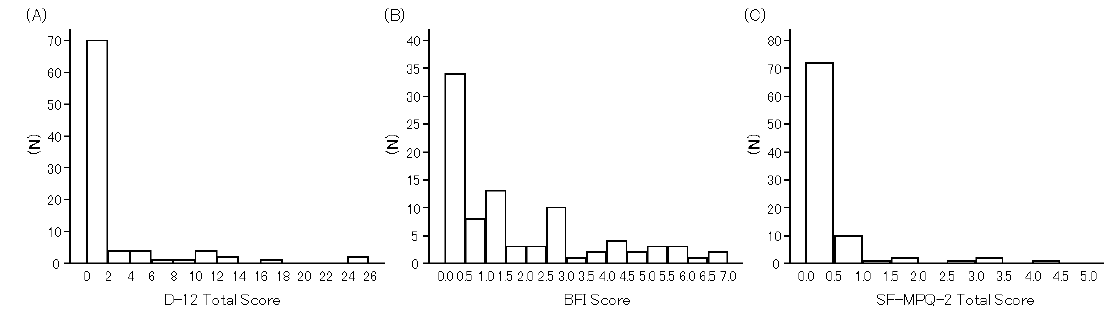
IQR, interquartile range; BFI, Brief Fatigue Inventory; SF-MPQ-2, Short-form McGill Pain Questionnaire 2; D-12, Dysp- noea-12.